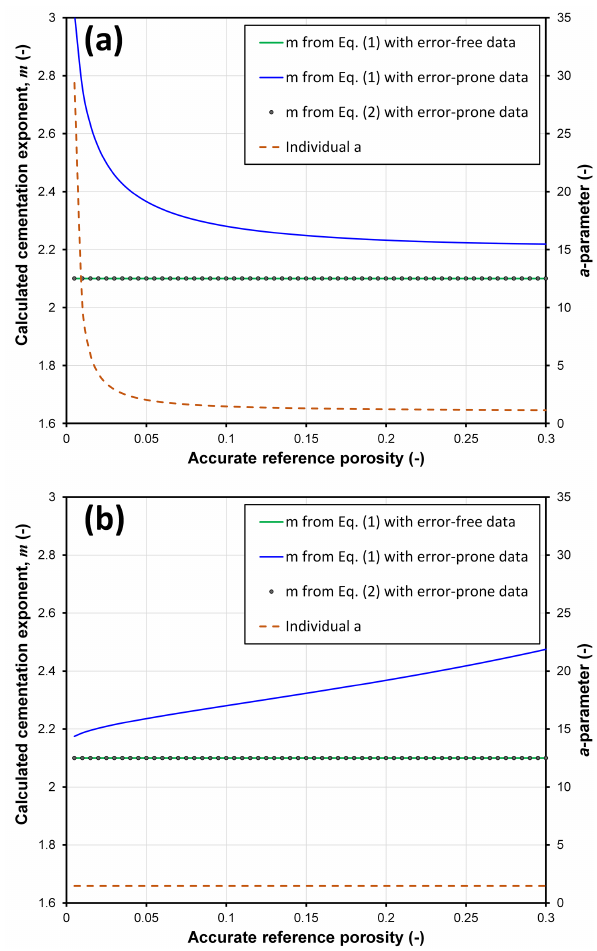
Figure 8. Modelling of the calculated cementation exponent and a parameter for error-free data and data containing two types of systematic error in porosity, (a) measured porosity exceeds the real porosity by 0.02, and (b) measured porosity exceeds the real poros- ity by a factor of 1.2. Solid curves and dots refer to the left-hand vertical axis. The orange dashed line refers to the right-hand